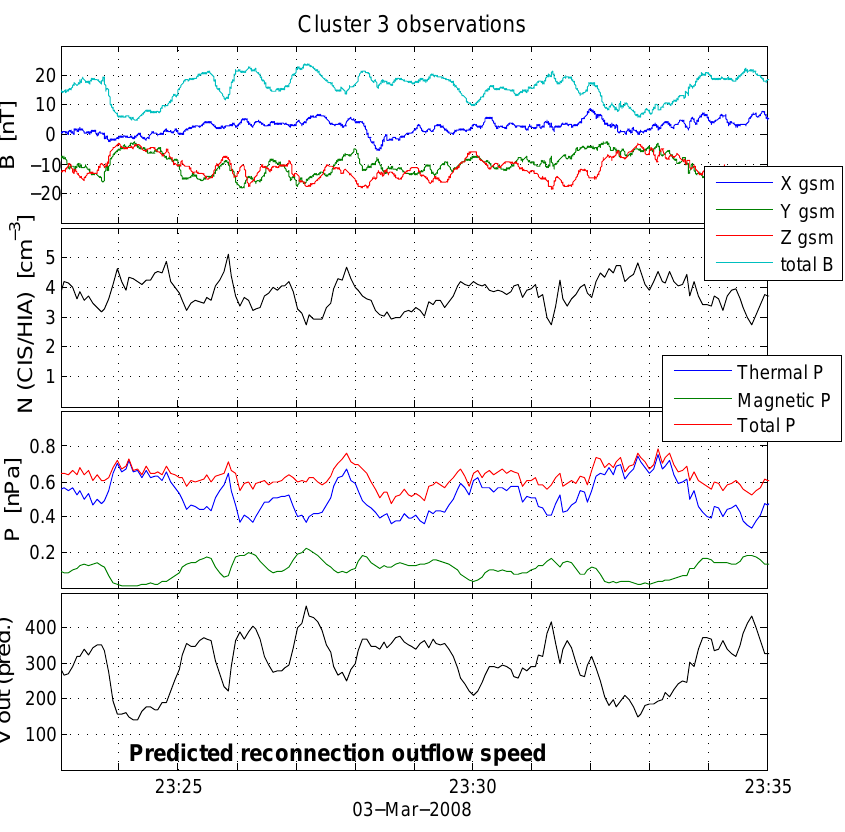
Fig. 1. Mirror modes in Cluster 3 observations, slightly after event 2. The first panel shows magnetic field components in GSM coordinates and the total magnetic field (light blue). In second panel, ion density. Third panel: plasma thermal pressure, magnetic pressure and their sum. The sum stays approximately constant, a typical property of mirror modes. Fourth panel shows the reconnection outflow velocity calculated by Eq. (2), using observed magnetosheath values from the first two panels and a constant value of B 1 = 28nT for the magnetosphere magnetic